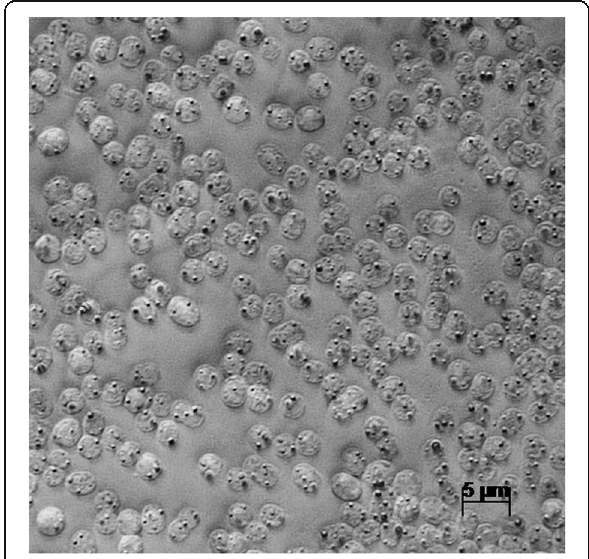
Fig. 1 Phase-contrast photomicrograph of “ T. syntrophicum ” sp. nov. strain Cad16 T . The elementary sulfur globule inclusions are visible as black dots within the